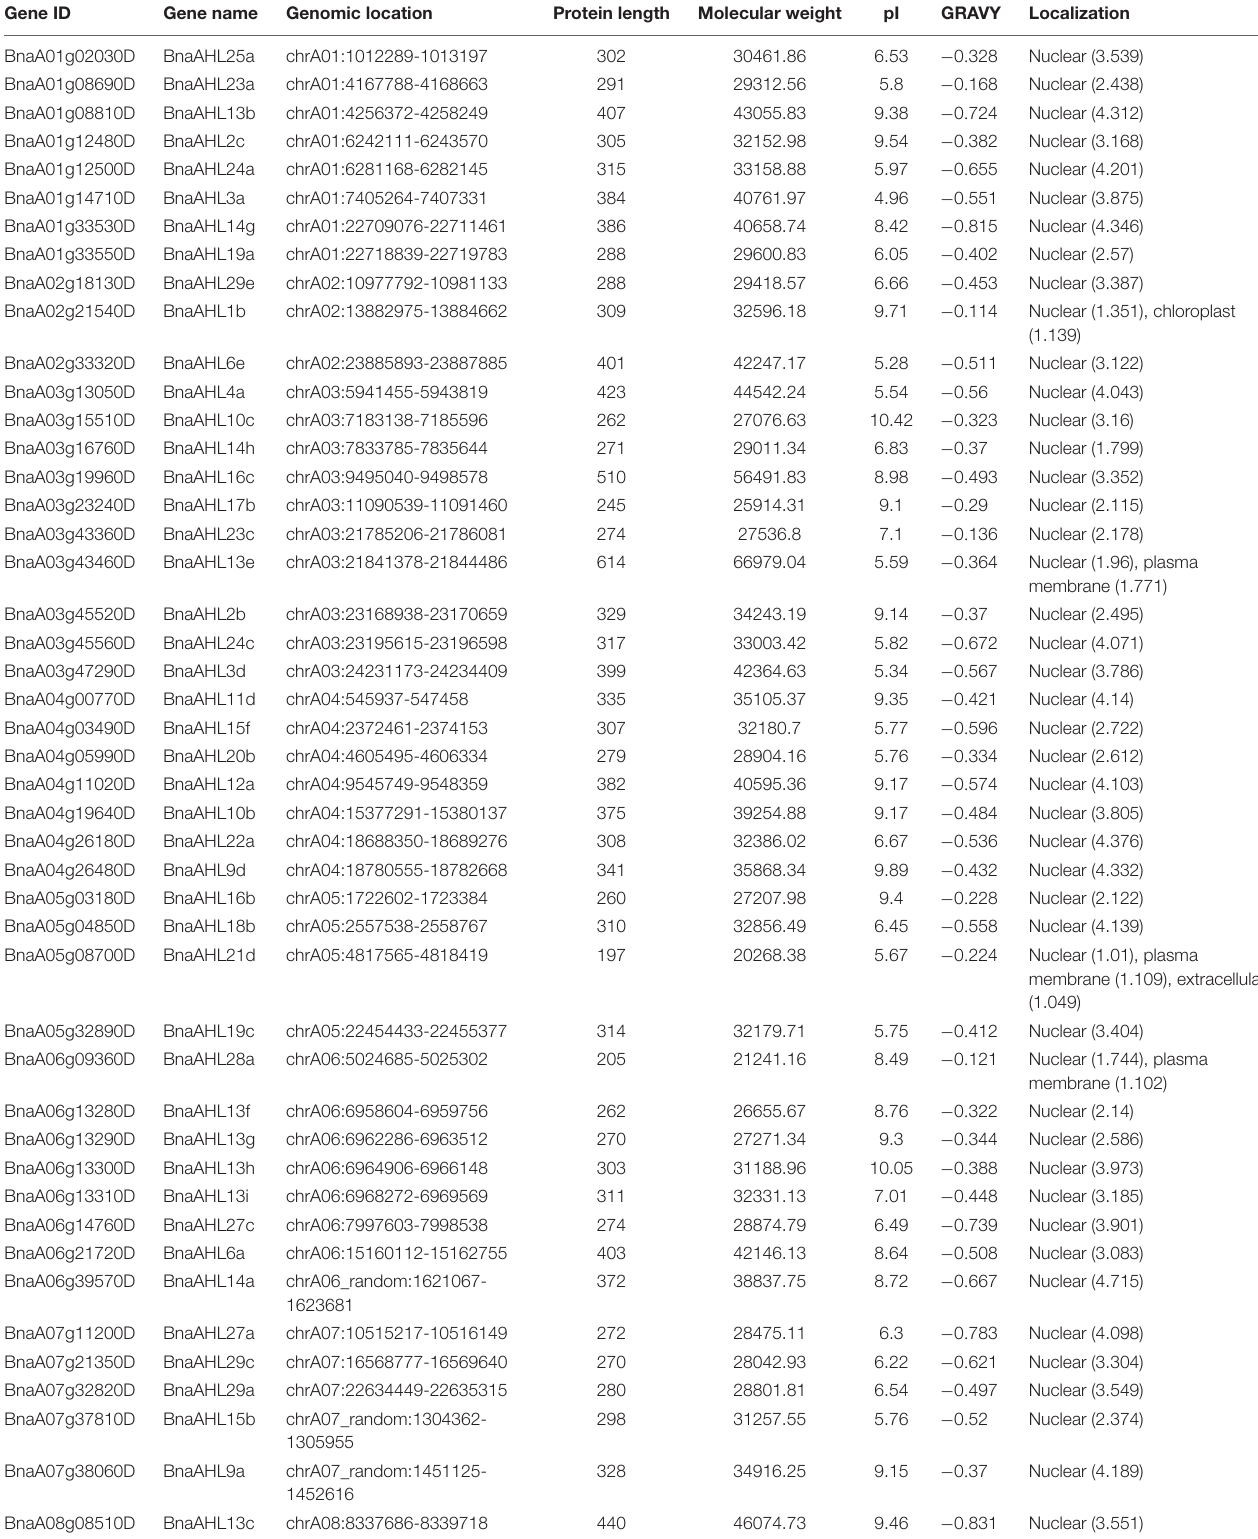
TABLE 1 | The information of BnaAHL gene family in B. napus